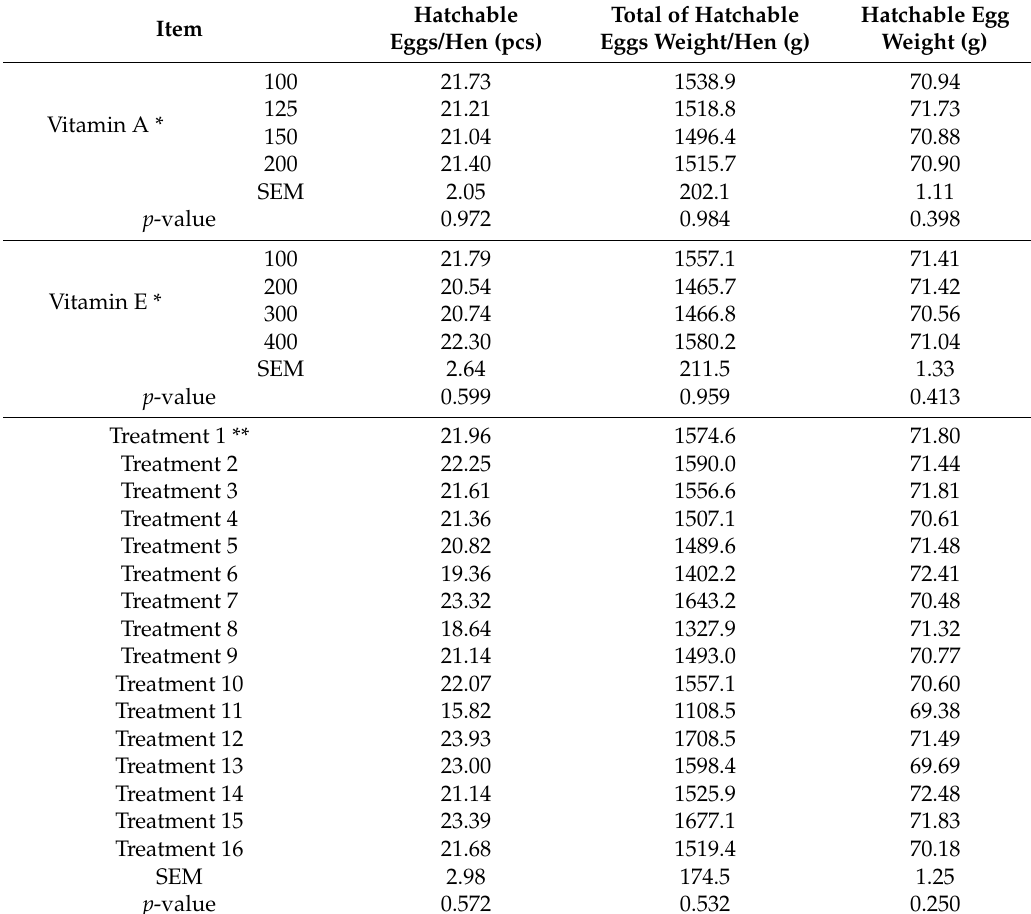
Table 2. Effect of dietary treatments on egg-related